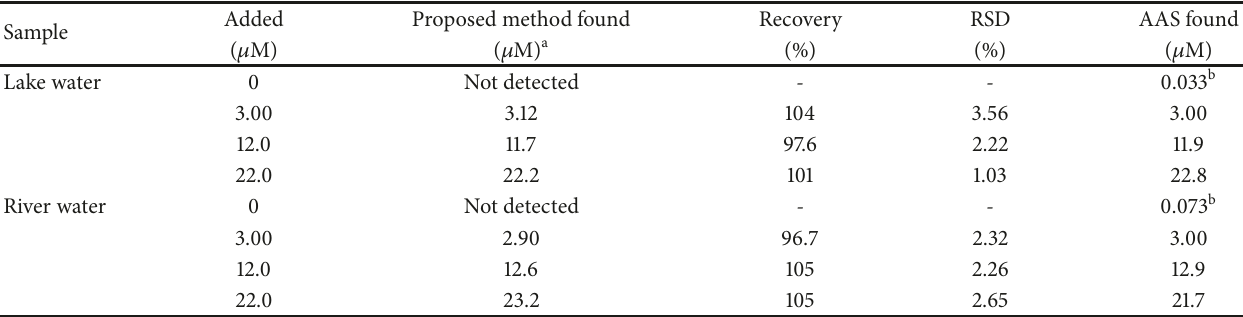
Table S1: Comparison of the present approach with other reported methods for the detection of Cr (VI) Table S2: Investigation of potential interferents in determination of Cr(VI) at 7.4 𝜇 M concentration. Figure S1: The excitation and emission fluorescence spectra of the F-hPEI capped Au NPs. Figure S2: (a) (A) (B) represent the fluorescence emission spectra of the F-hPEI-capped Au NPs in the absence and presence of 160 𝜇 M Cr(VI), line C is the sensor containing 160 𝜇 M Cr(VI) and 1.2 × 10 3 𝜇 M Fe(II) ion. (b) The fluorescence emission spectra of the F-hPEI-capped Au NPs containing 3 𝜇 3 𝜇 M and 1.4 × 10 160 𝜇 M Cr(VI) in the presence of 1.2 × 10